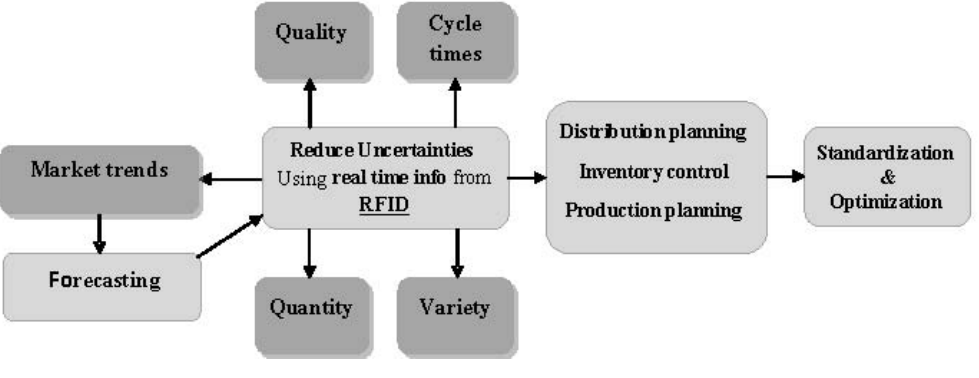
Figure 1. “Conceptual model”. Source: